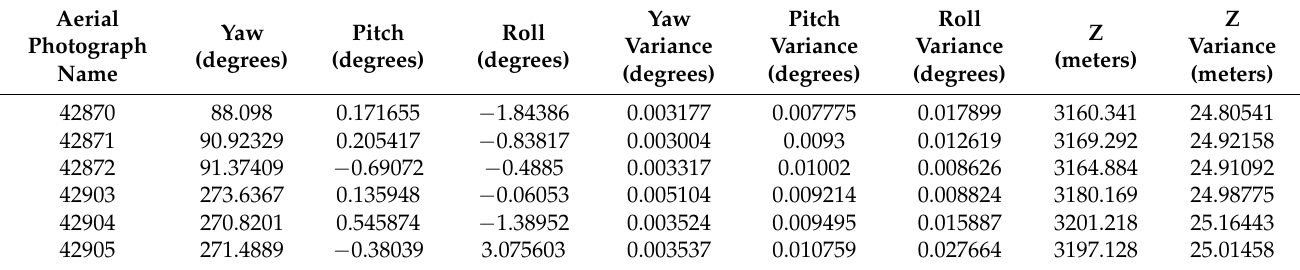
Table 3. Orientation values for each axis (Yaw, Pitch and Roll) estimated by the software for each 1963 aerial photograph. The variance of each axis and the estimated camera elevation is also listed. The values, being a product of the image alignment, are common to all 12 methods used to reconstruct the 1963 digital surface models.